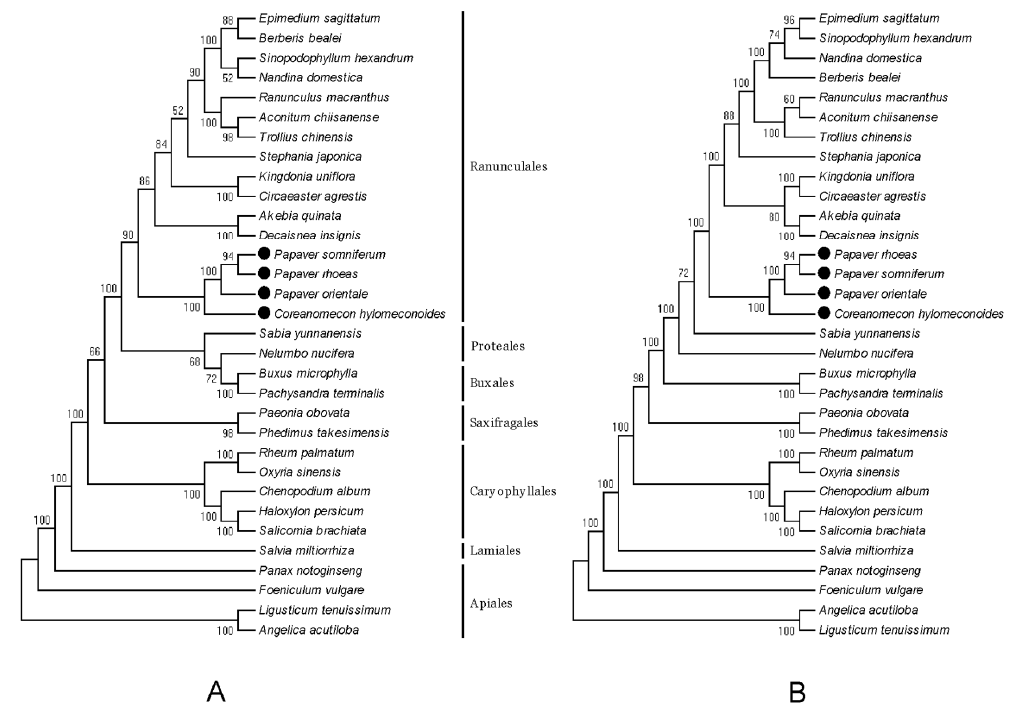
Figure 8. Phylogenetic trees constructed with 54 protein-coding genes of 32 species using maximum likelihood (ML) and maximum parsimony (MP) methods. Numbers at nodes are values for bootstrap support. These trees are unrooted cladograms. ( A ) ML tree; ( B ) MP tree.